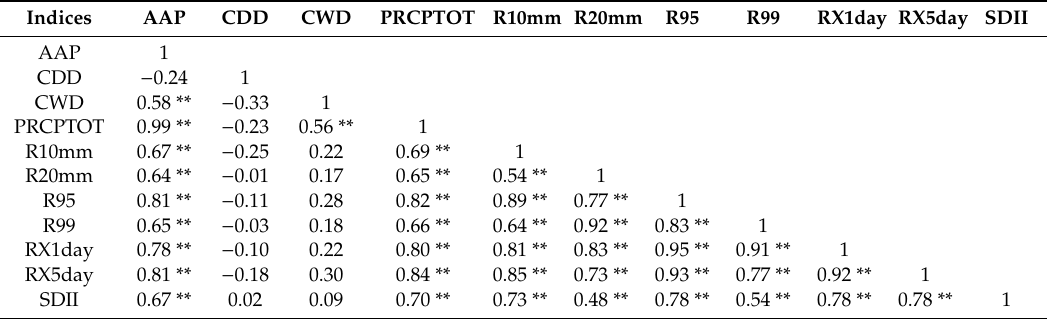
Table A3. Correlation coe ffi cients between annual average precipitation (AAP) and the extreme precipitation indices in desert